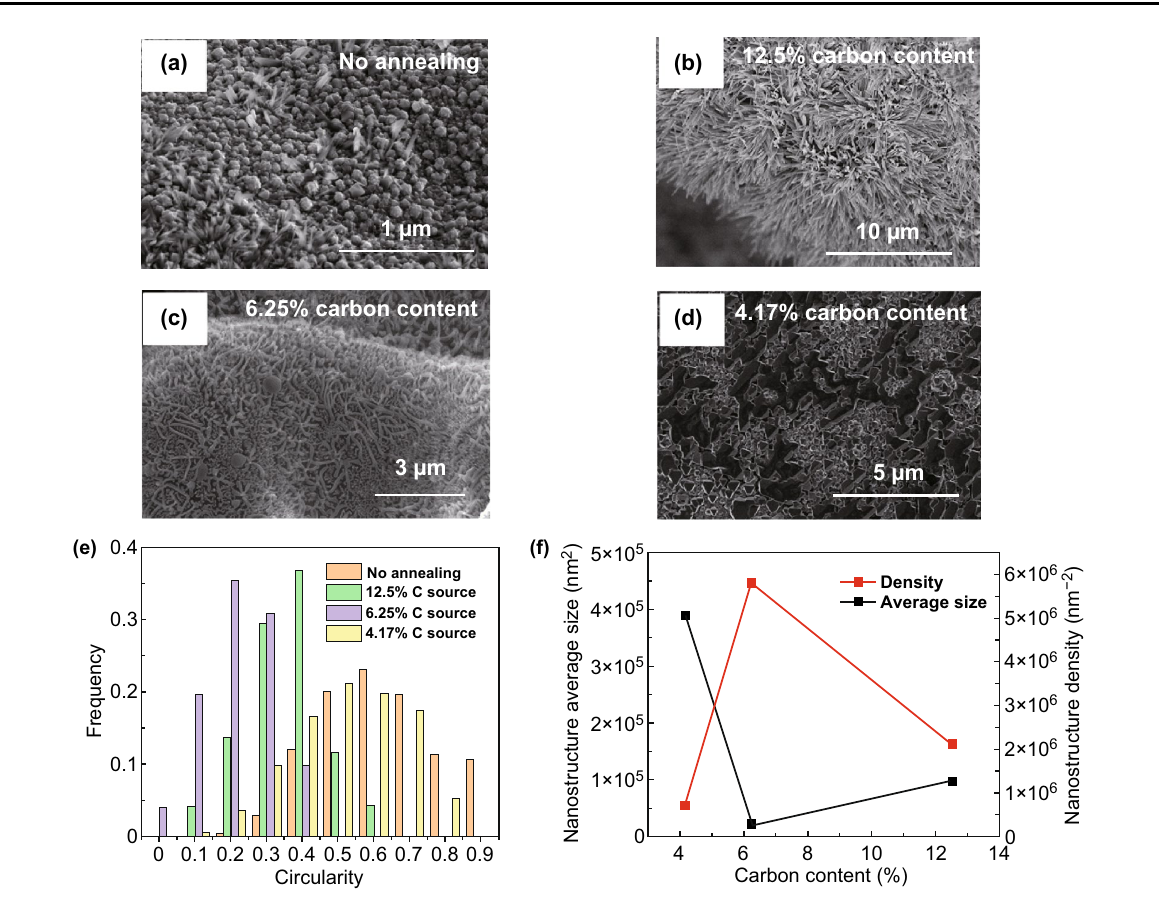
Fig. 2 a Scanning electron microscopy (SEM) image of nanocore Ni 3 Si 2 nanostructure. b SEM image of nanowire Ni 3 Si 2 nanostructure. c SEM image of creeper-like Ni 3 Si 2 nanostructure. d SEM image of amorphous Ni 3 Si 2 nanostructure. e Circularity frequency distribution. f Time- dependent variation in the average size and density of creeper-like Ni 3 Si 2 /NiOOH/graphene nanostructures on 3D graphene/Ni foam. The